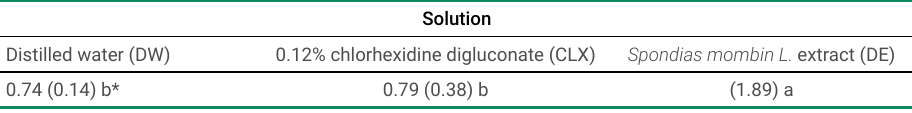
Table 4. Mean (standard deviation) of the color change (ΔE00) according to the solution tested.